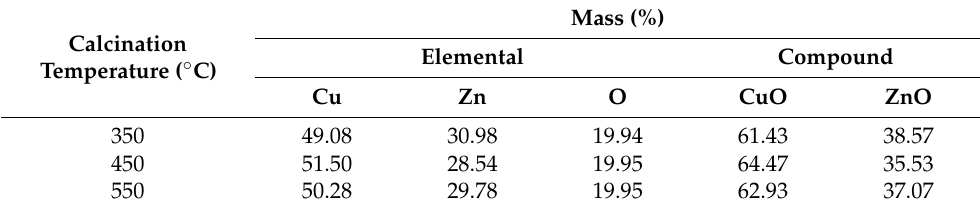
Figure 4. SEM images of Cu x Zn y O mixed metal oxide nanoparticles calcined at ( a ) 350 °C, ( b ) 450 °C, and ( c ) 550 °C. Table 1. EDX analysis data obtained for Cu x Zn y O mixed metal oxide nanoparticles calcined at 350, 450, and 550 ◦ C.